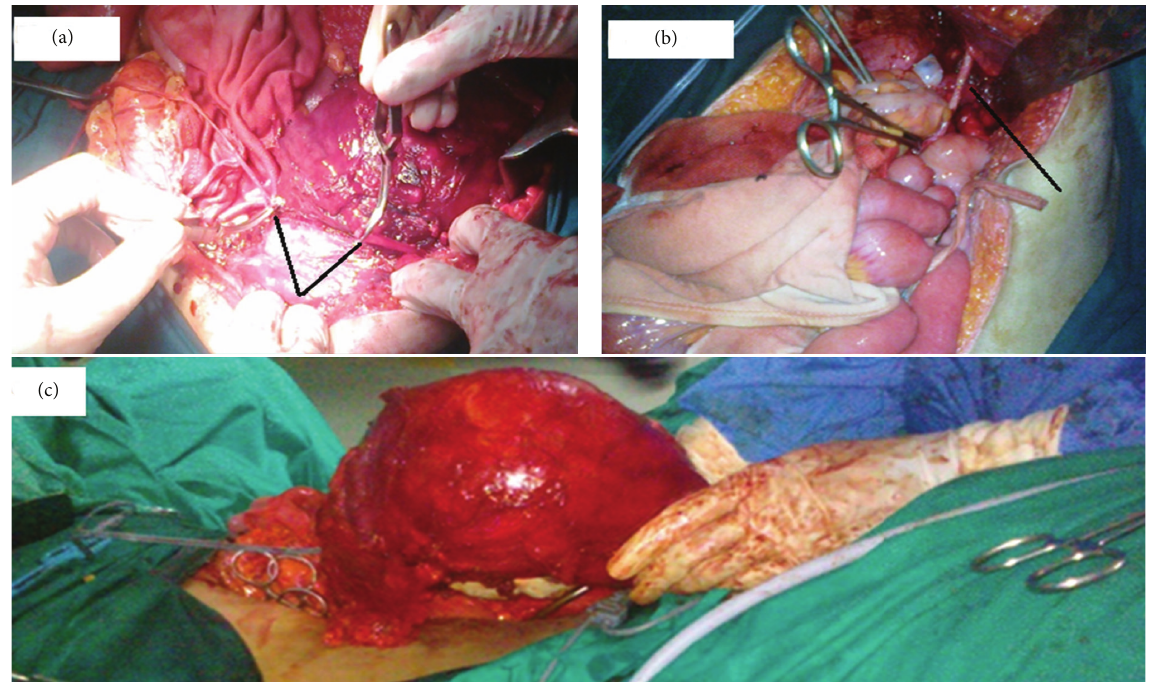
Figure 2: (a) Right external iliac artery cut prior to mobilization and held with bulldog clamps (V arrow showing cut edges of the artery). (b) Right external iliac artery after re-anastomosis (black line showing point of anastomosis). (c) En-bloc radical excision specimen.